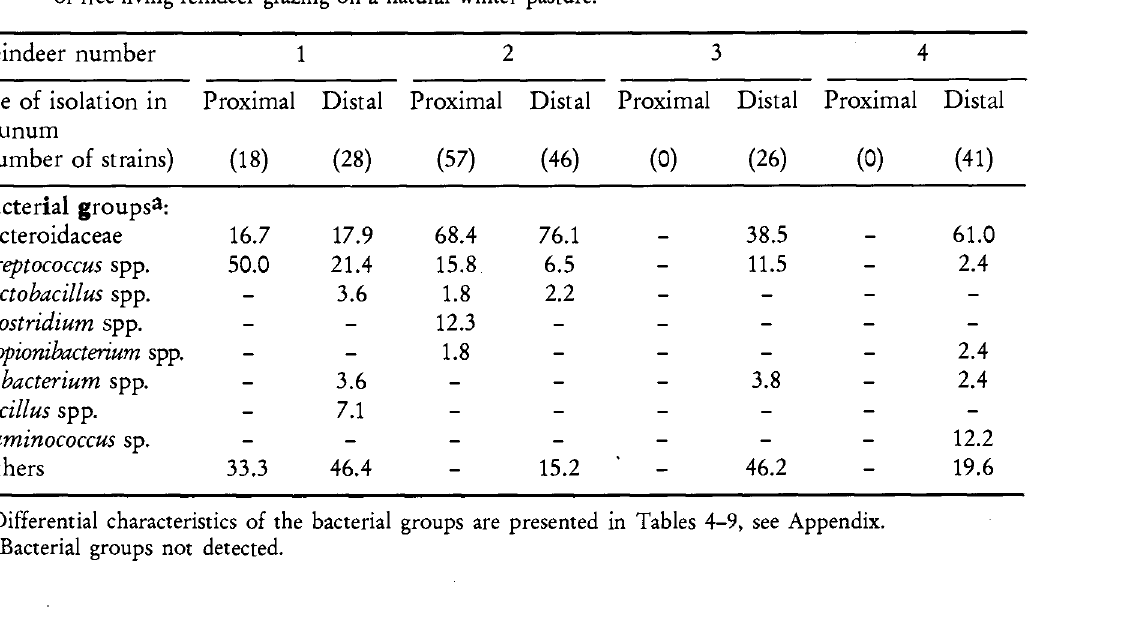
(Table 8). Bacteroides spp. (strains B28—29, and B3D, sp. (strain E3) and unidentified gram positive, single cocci (strains U23—24) were found in reindeer No. 4 (Table 9). The bacterial